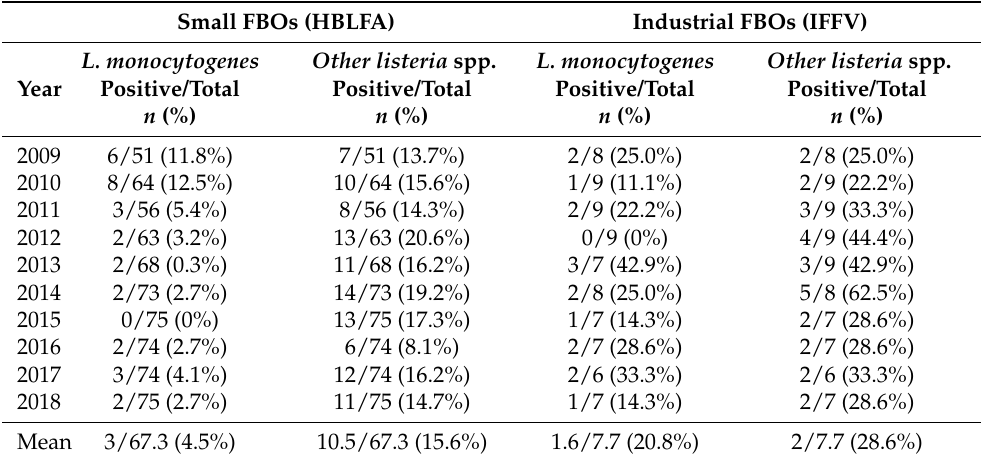
Table 1. Numbers of small and industrial food establishments (FBOs) that tested positive for L. monocytogenes and other Listeria spp., which participated in the Listeria monitoring program